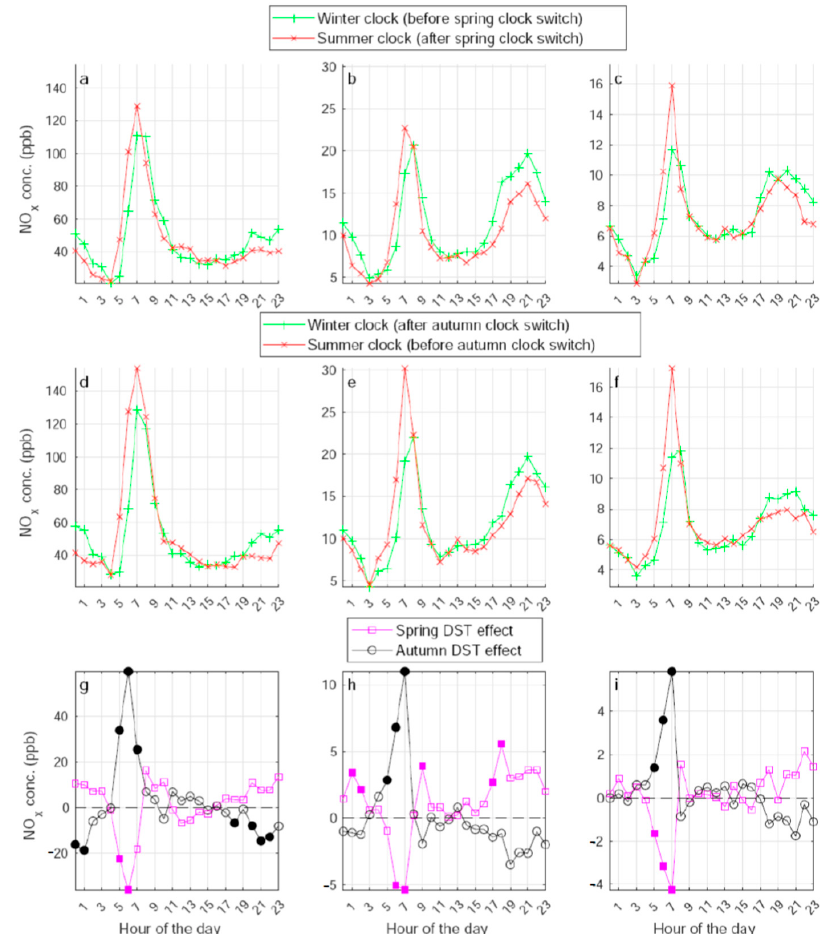
Figure 3. Daily cycles of NOx, averaged over five working days before and after the DST clock changes, at AQM stations Remez (left column), Bet Shemesh (middle column), and Karmiel (right column) (see Figure 1). Upper row ( a – c )—daily NOx concentration cycles in the spring; middle row ( d – f )—daily NOx concentration cycles in the autumn; lower row ( g – i )—daily cycles of the DST effect (the difference between the median NOx concentrations before and after the DST clock change at corresponding hours of the day). Filled symbols denote differences that are statistically significant at the p = 0.01 level.